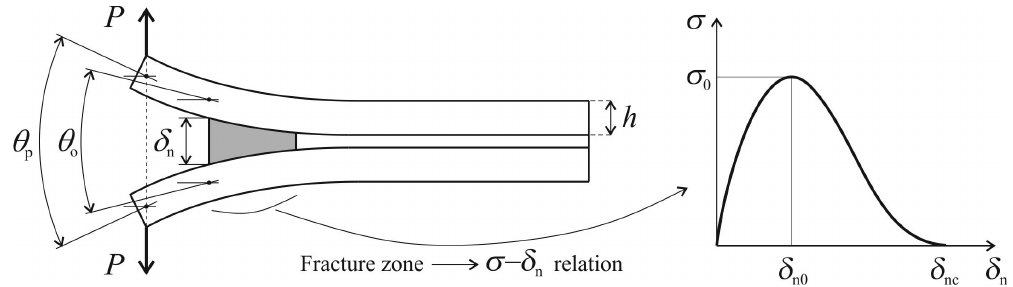
Figure 2: DCB specimen under loading, with description of the analysis